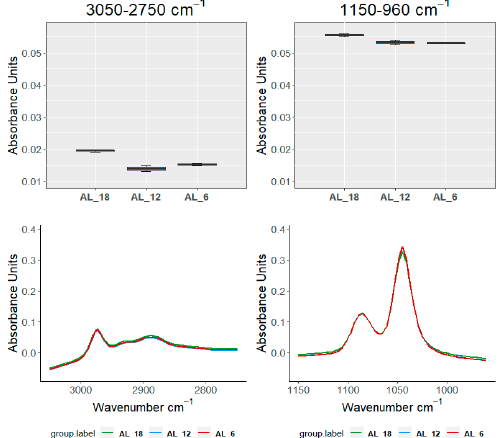
Figure 7. Plots of two of the four significant areas of the Alternative Oak (AL) curves. In the first row, vectorial analysis by means of boxplots. In the second row, FDA through curves in the studied interval. The wine spirit sample is divided into three groups depending on the ageing time (18, 12, and 6 months of